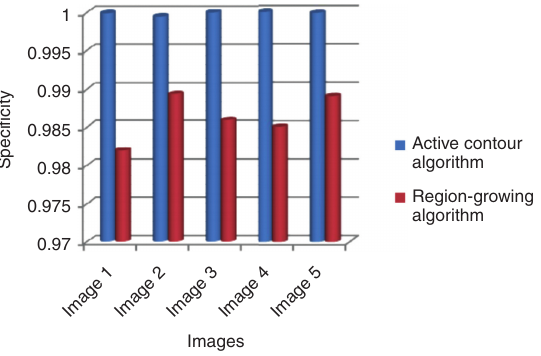
Figure 5: Specificity Comparison of the Proposed Segmentation.